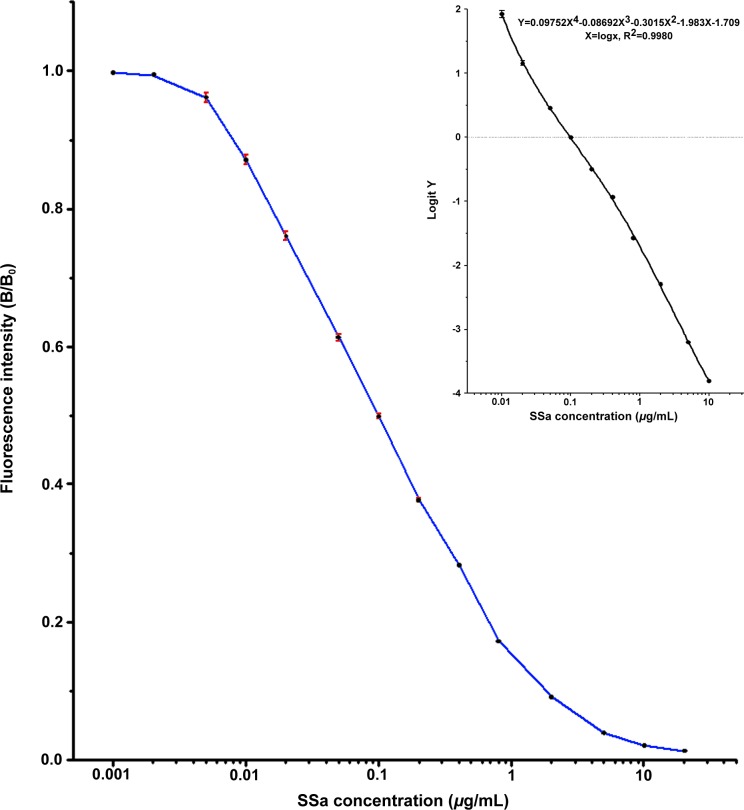
Standard curve of SSa content detected by TRFIA.The main body represents the dose-response curve between SSa concentrations and the reporting fluorescence values (B/B0), whereas the inserted smaller figure demonstrates the calibration curve acquired after log-logit treatment, showing a good fourth order polynomial fit. Each point represents the mean±SD of 10 assays in duplicate.